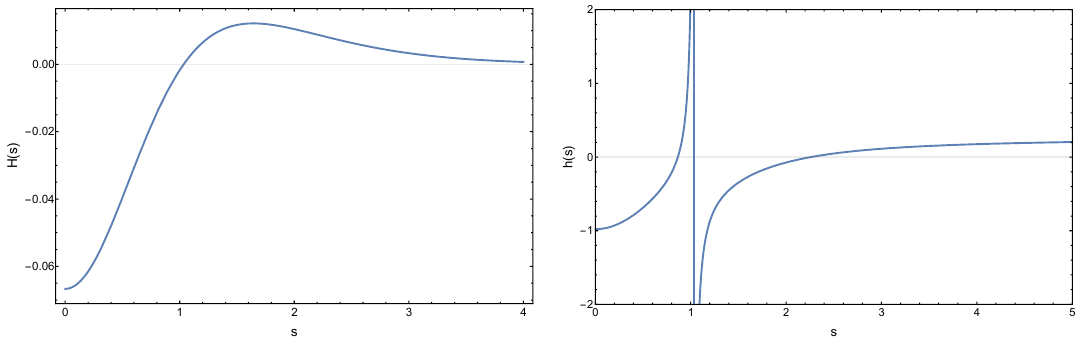
p λ/ 2 vx . The modulus . s